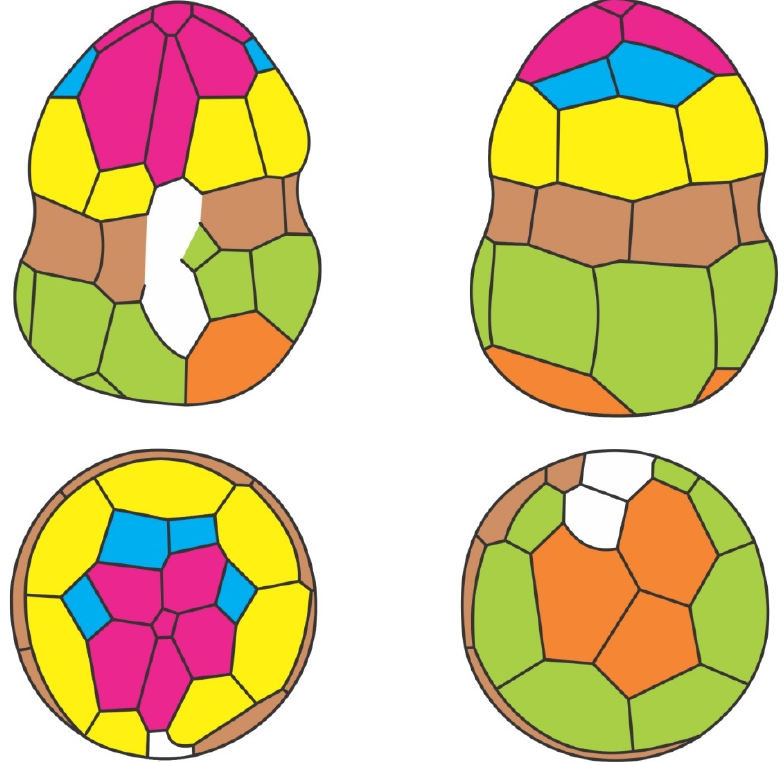
Figure 20. Reflected tabulation of the rhaetogonyaulacinean genus Dapcodinium : Top left: ventral view; Top right: dorsal view; Bottom left: apical view; Bottom right: antapical view. The different colours represent the lateral plate series, except that blue represents intercalary plates. Because the number of plates anterior to the precingulars and posterior to the postcingulars may be variable in number and arrangement in this group, apical and anterior intercalary plates may be referred to collectively as climactal plates and antapical and posterior intercalary plates may be referred to collectively as fundital plates. Modified from [43].